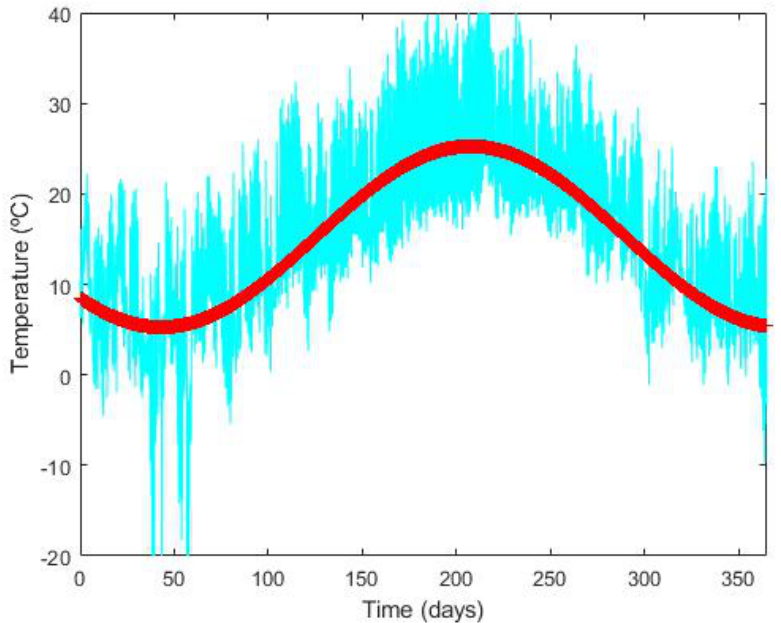
Figure 6. Ambient temperature during 2018 (cyan) and its prediction